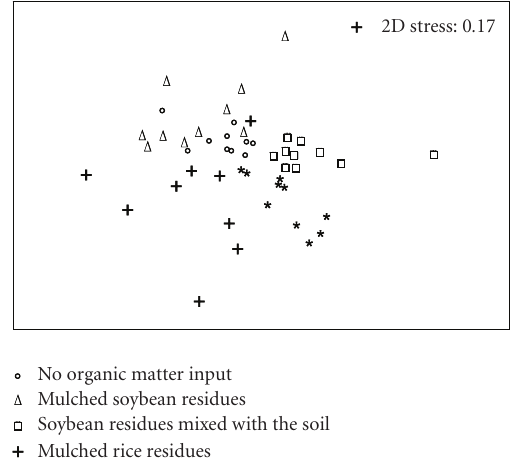
Figure 1: Multidimensional scaling analysis (MDS) of nemato- fauna structure for the di ff erent organic matter treatments ( n = 10 in each